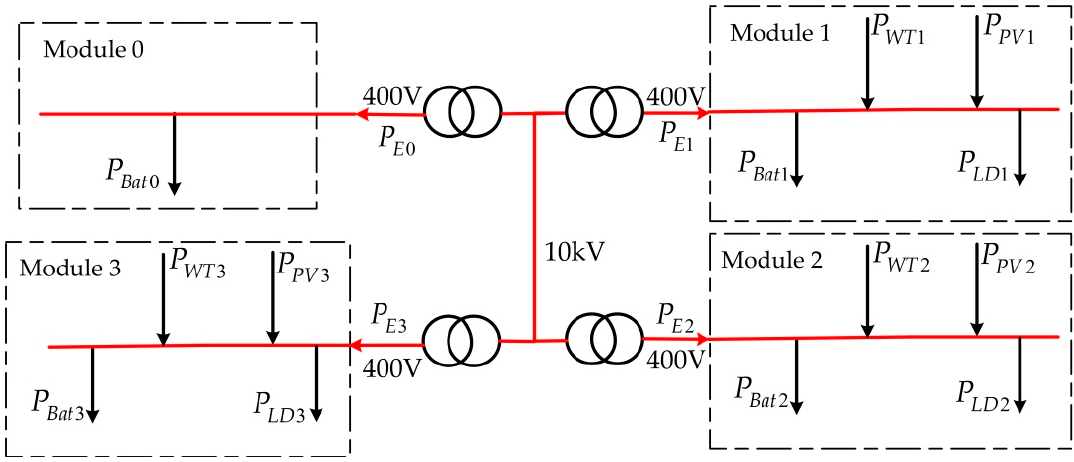
Figure 4. Power flow chart of the modular microgrid.